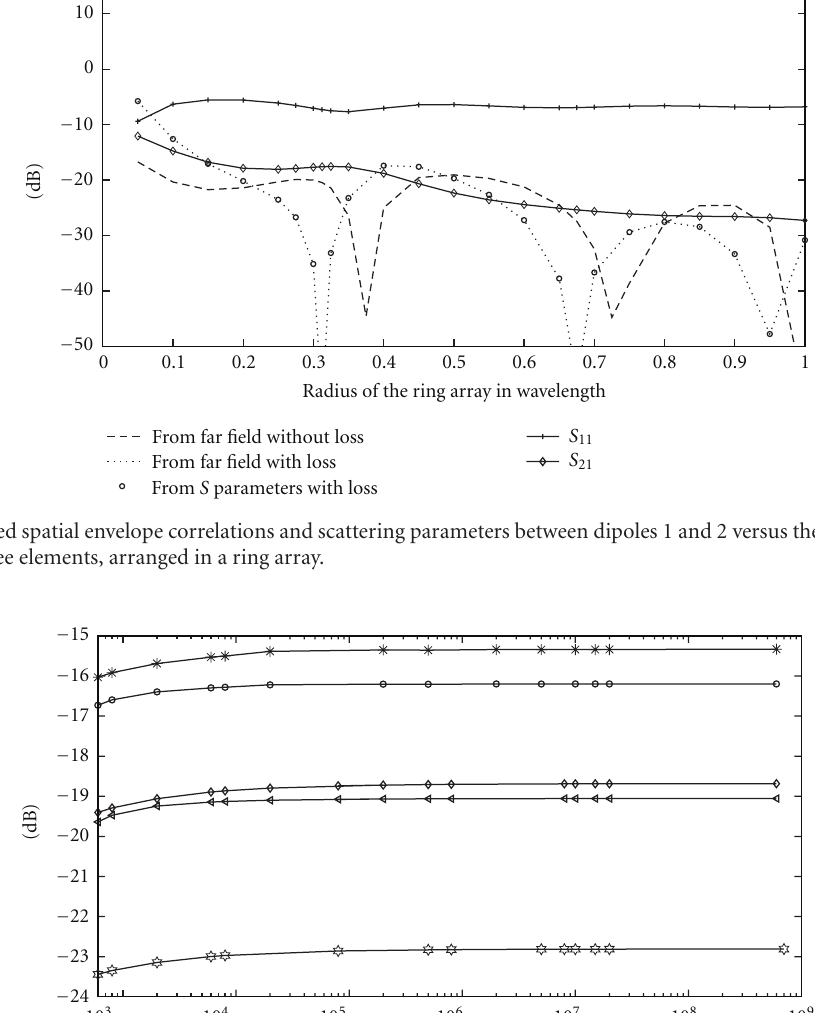
0.5 dB of the S 21 values for the uniform linear array and ring array,